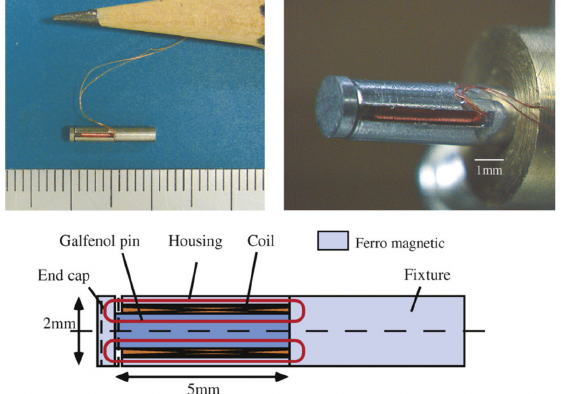
Figure 4. A Galfenol micro-actuator presented in [78]. Reprinted with permission from